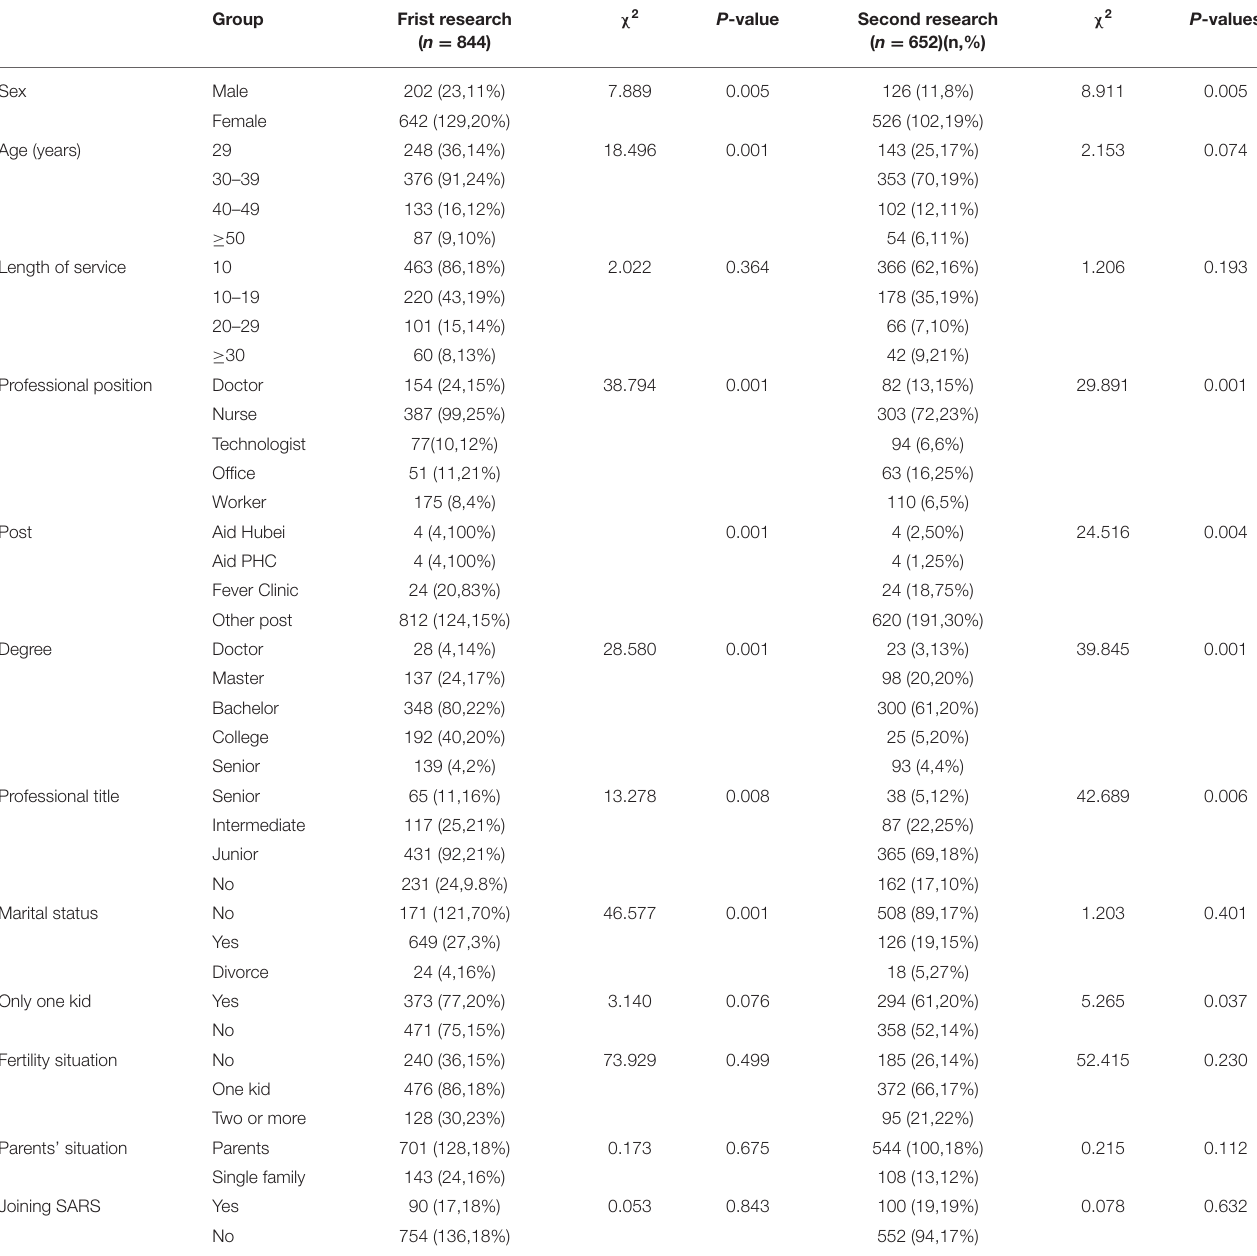
TABLE 2 | Basic situation of the subjects of the two surveys [total number of people (positive number > 160 points)]. χ 2 P -value Second research χ 2 P Group Frist research ( n = 844) ( n = 652)(n,%)